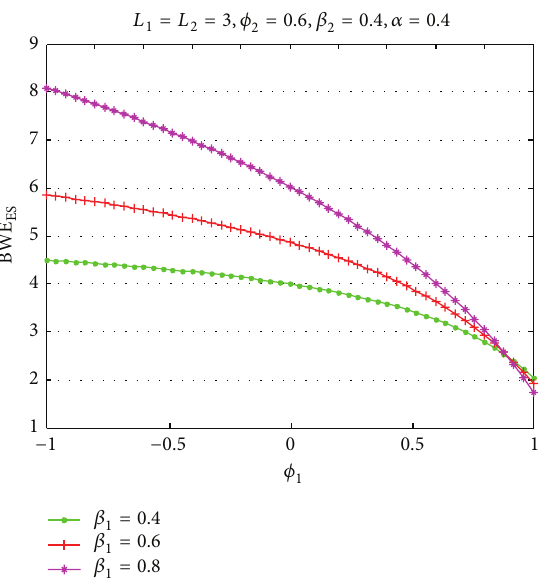
Figure 11: Impact of 𝜙 1 on bullwhip effect for different 𝛽 1 under the ES.